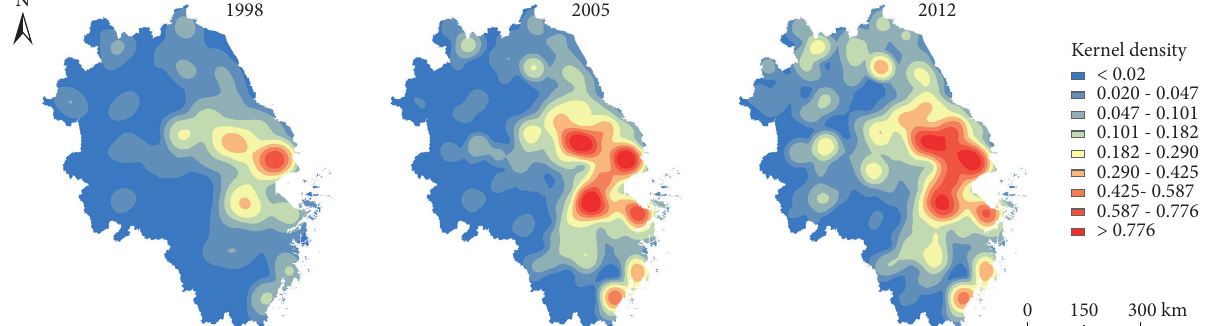
Figure 6: Kernel density estimation of water pollution-intensive enterprises in the lower reaches of the Yangtze River Economic Belt.